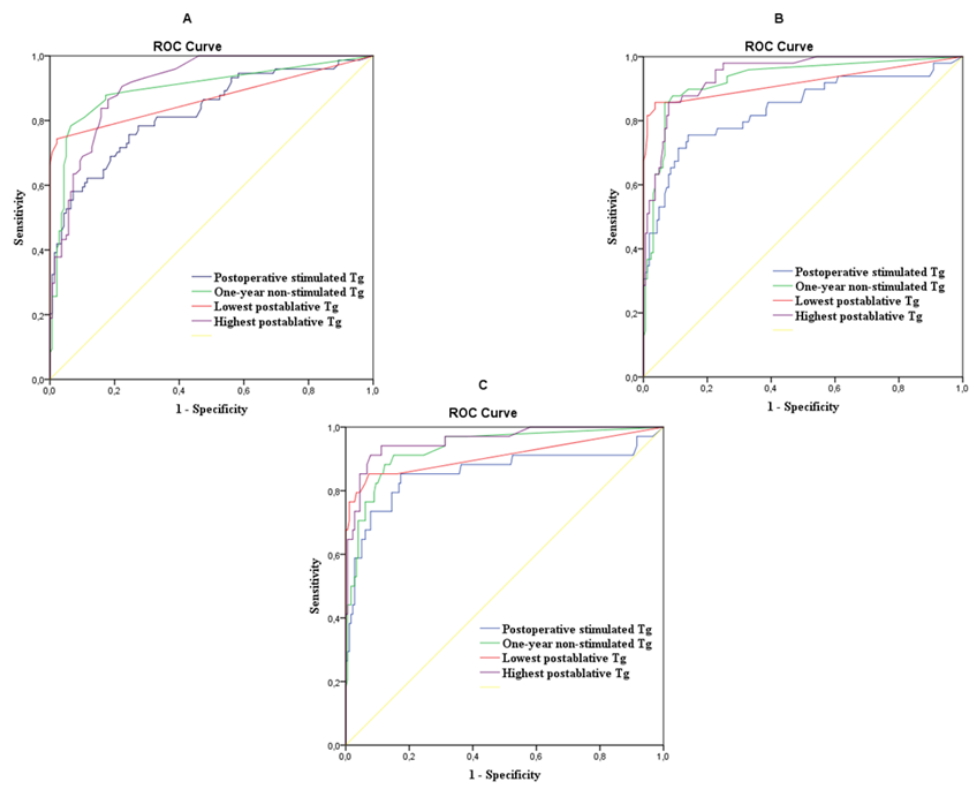
Figure 1. The diagnostic benefit of thyroglobulin values in the prediction of a therapeutic response during ROC analyses. ( A ) Tumor free versus uncertain + incomplete biochemical response + structural disease at the end of follow-up. ( B ) Tumor free + uncertain versus incomplete biochemical response + structural disease at the end of follow-up. ( C ) Tumor free + uncertain + incomplete biochemical response versus structural disease at the end of follow-up.